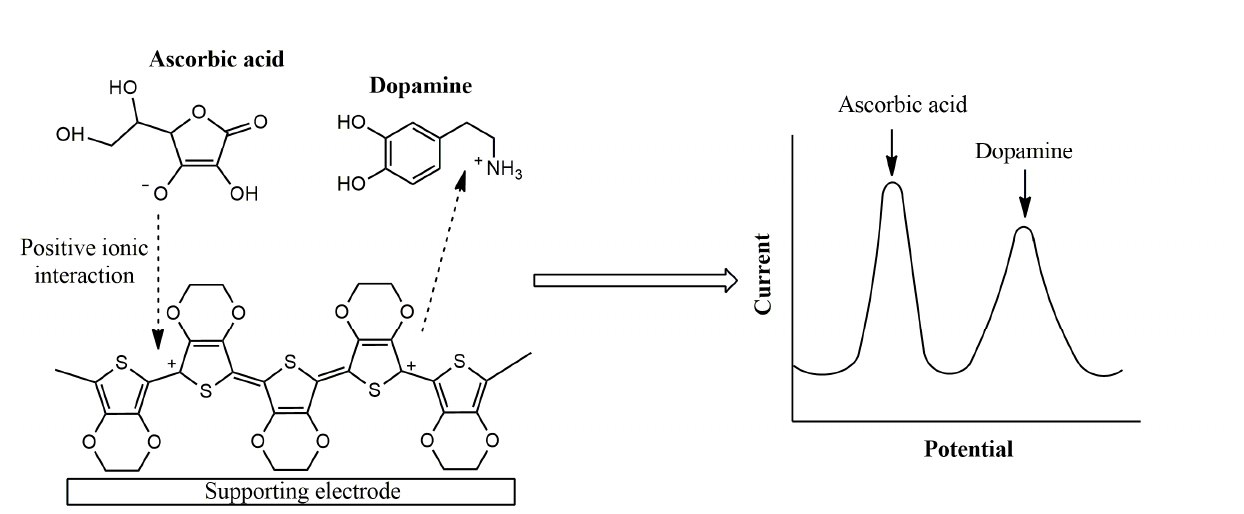
Figure 4. Proposed mechanism for ascorbic acid and dopamine interaction using PEDOT-modified electrodes.